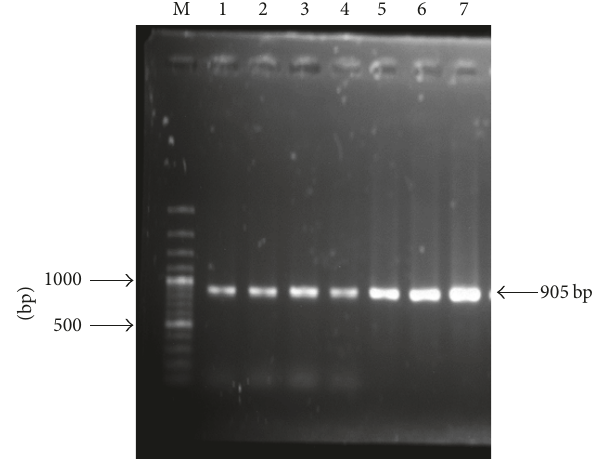
Figure 5: Agarose gel electrophoresis of PCR assay products. Lane M: 100bp DNA ladder (Thermo Scientific); lanes 1–6: DNA of Brucella species from seronegative bovine milk (905 bp); lane 7: positive